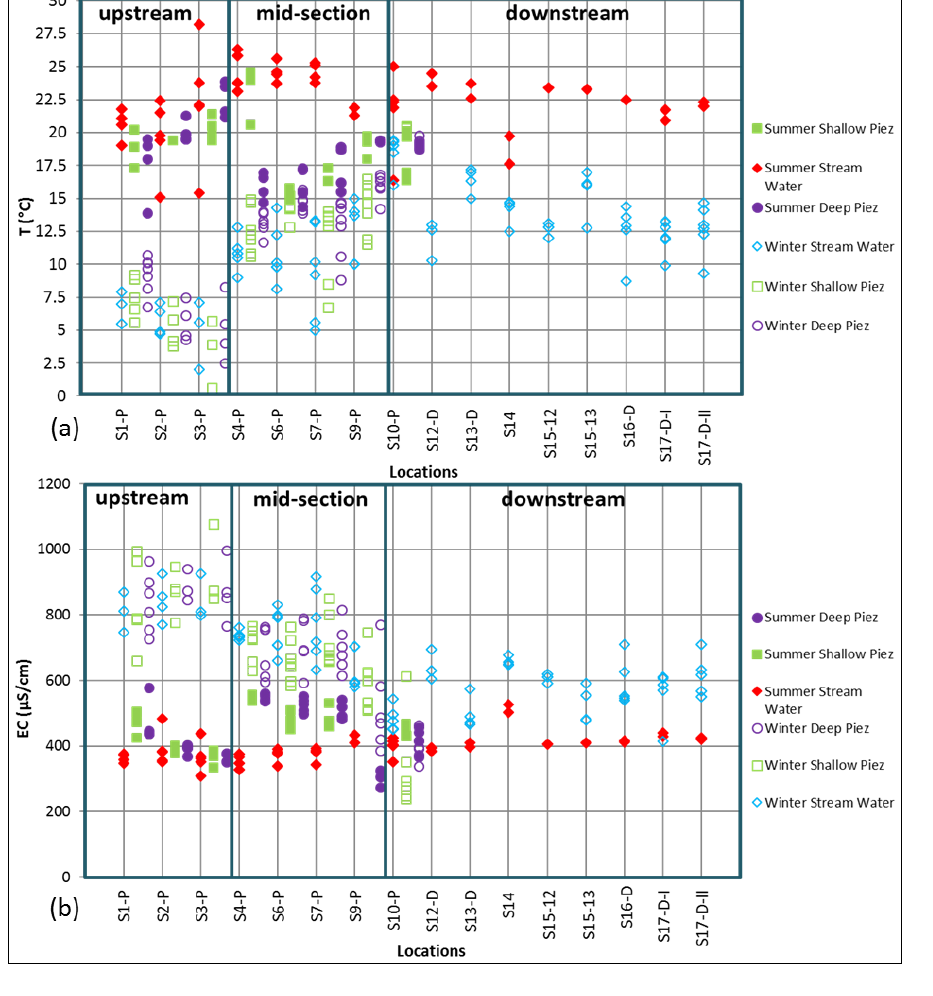
Figure 10. Variation in ( a ) temperature ( b ) EC values for stream water and piezometers at the monitoring locations.